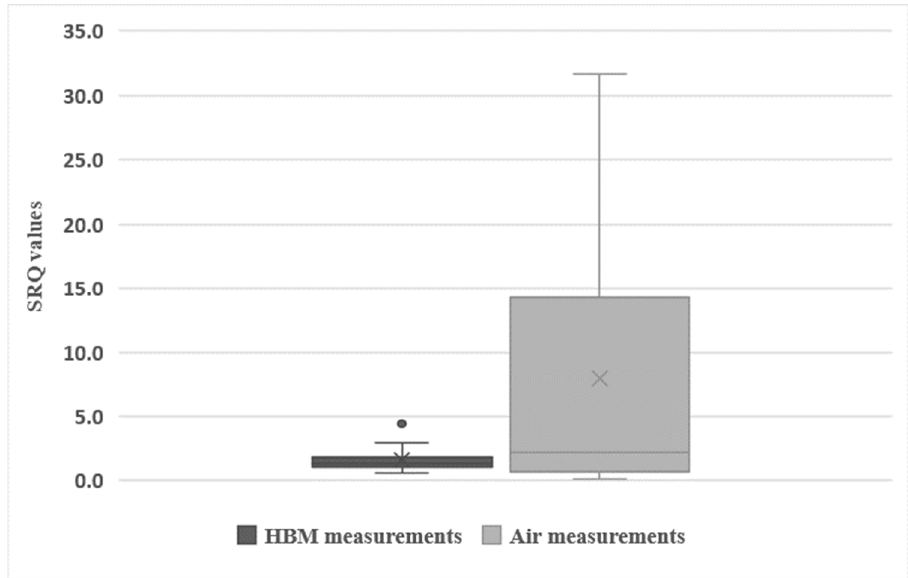
Figure 3. Boxplot showing the SRQ determined using values from air measurements (light grey) or using HBM measurements (dark grey). •—outlier; × —mean SRQ values (mean (HBM) = 1.62; mean (air) =